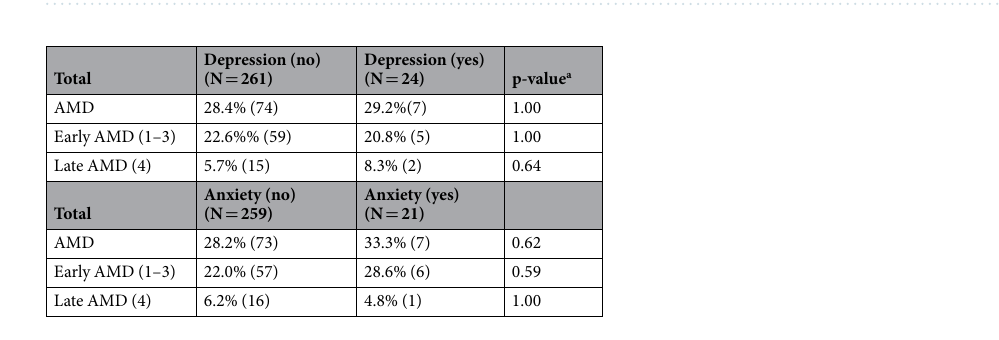
Table 7. Prevalence of depression and anxiety in a subsample with visual acuity > 0.3 logMar of the best eye. a chi-square test. Abbreviations: AMD (age-related macular